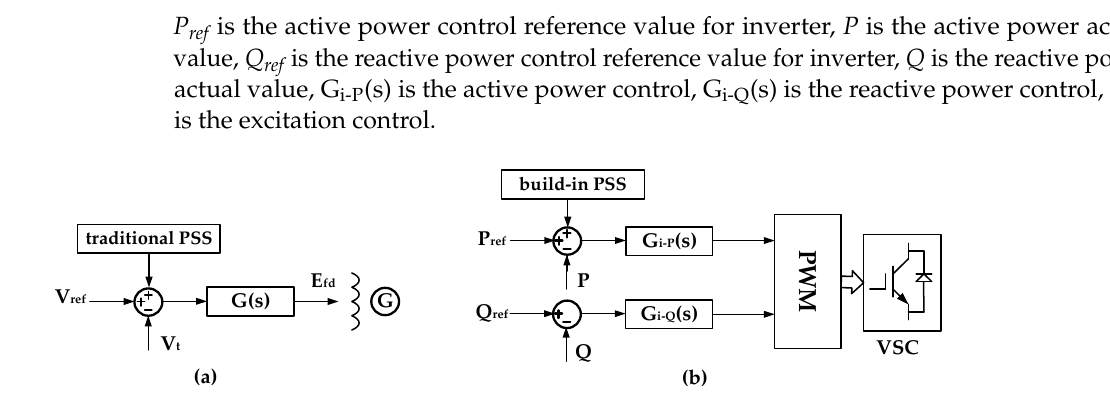
Figure 1. Traditional PSS in excitation system and the proposed built-in PSS in inverter. ( a ) Traditional PSS in excitation system; ( b ) the proposed built-in PSS in inverter.